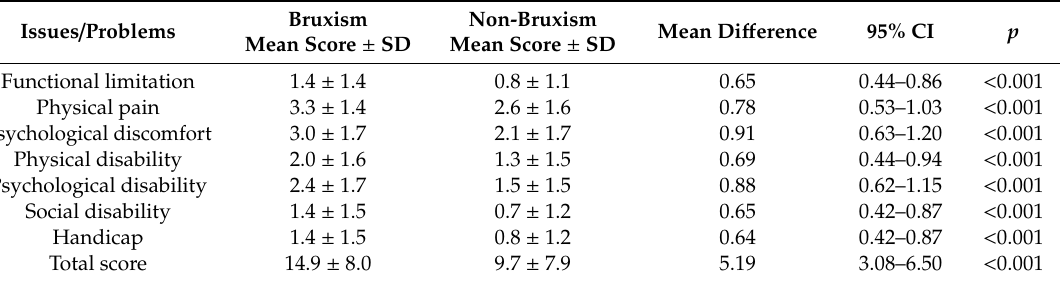
Table 5. E ff ects of bruxism on the oral health-related quality of